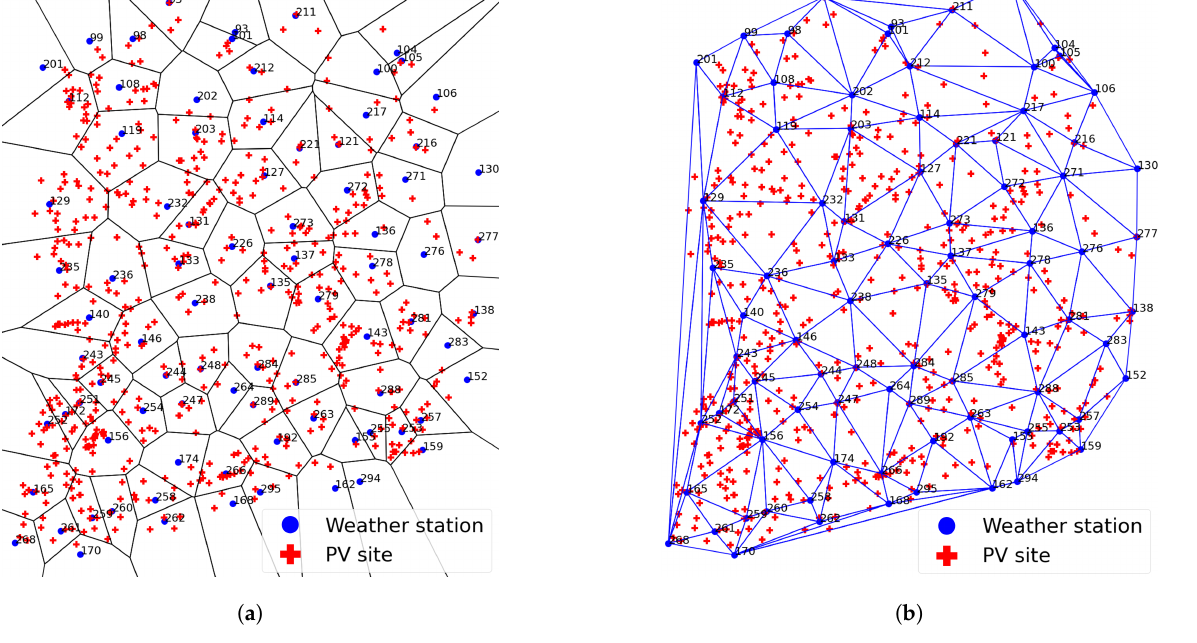
Figure 2. PV sites (red cross), Voronoi diagram and Delaunay triangulation of weather stations (blue circle) in Korea. ( a ) Voronoi diagram of weather stations. ( b ) Delaunay triangulation of weather